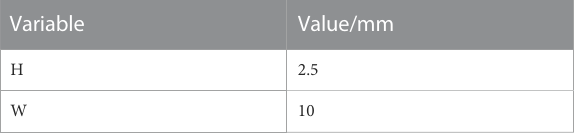
Figure 1. The geometric dimensions used in the current numerical study are shown in Table 1. The aspect ratio of the computational domain is 4. Speci fi cally, the height of the fl uid